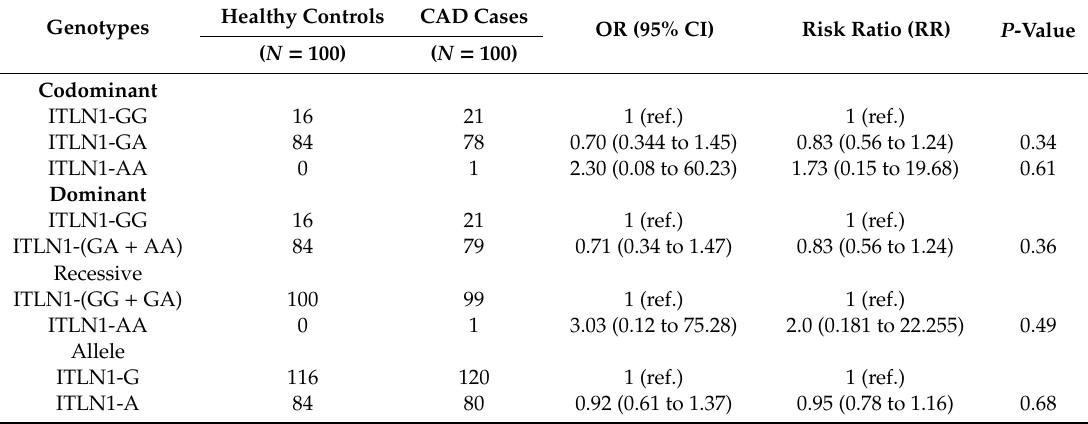
Table 7. Association of omentin rs2274908 G > A gene variation with the susceptibility to CAD